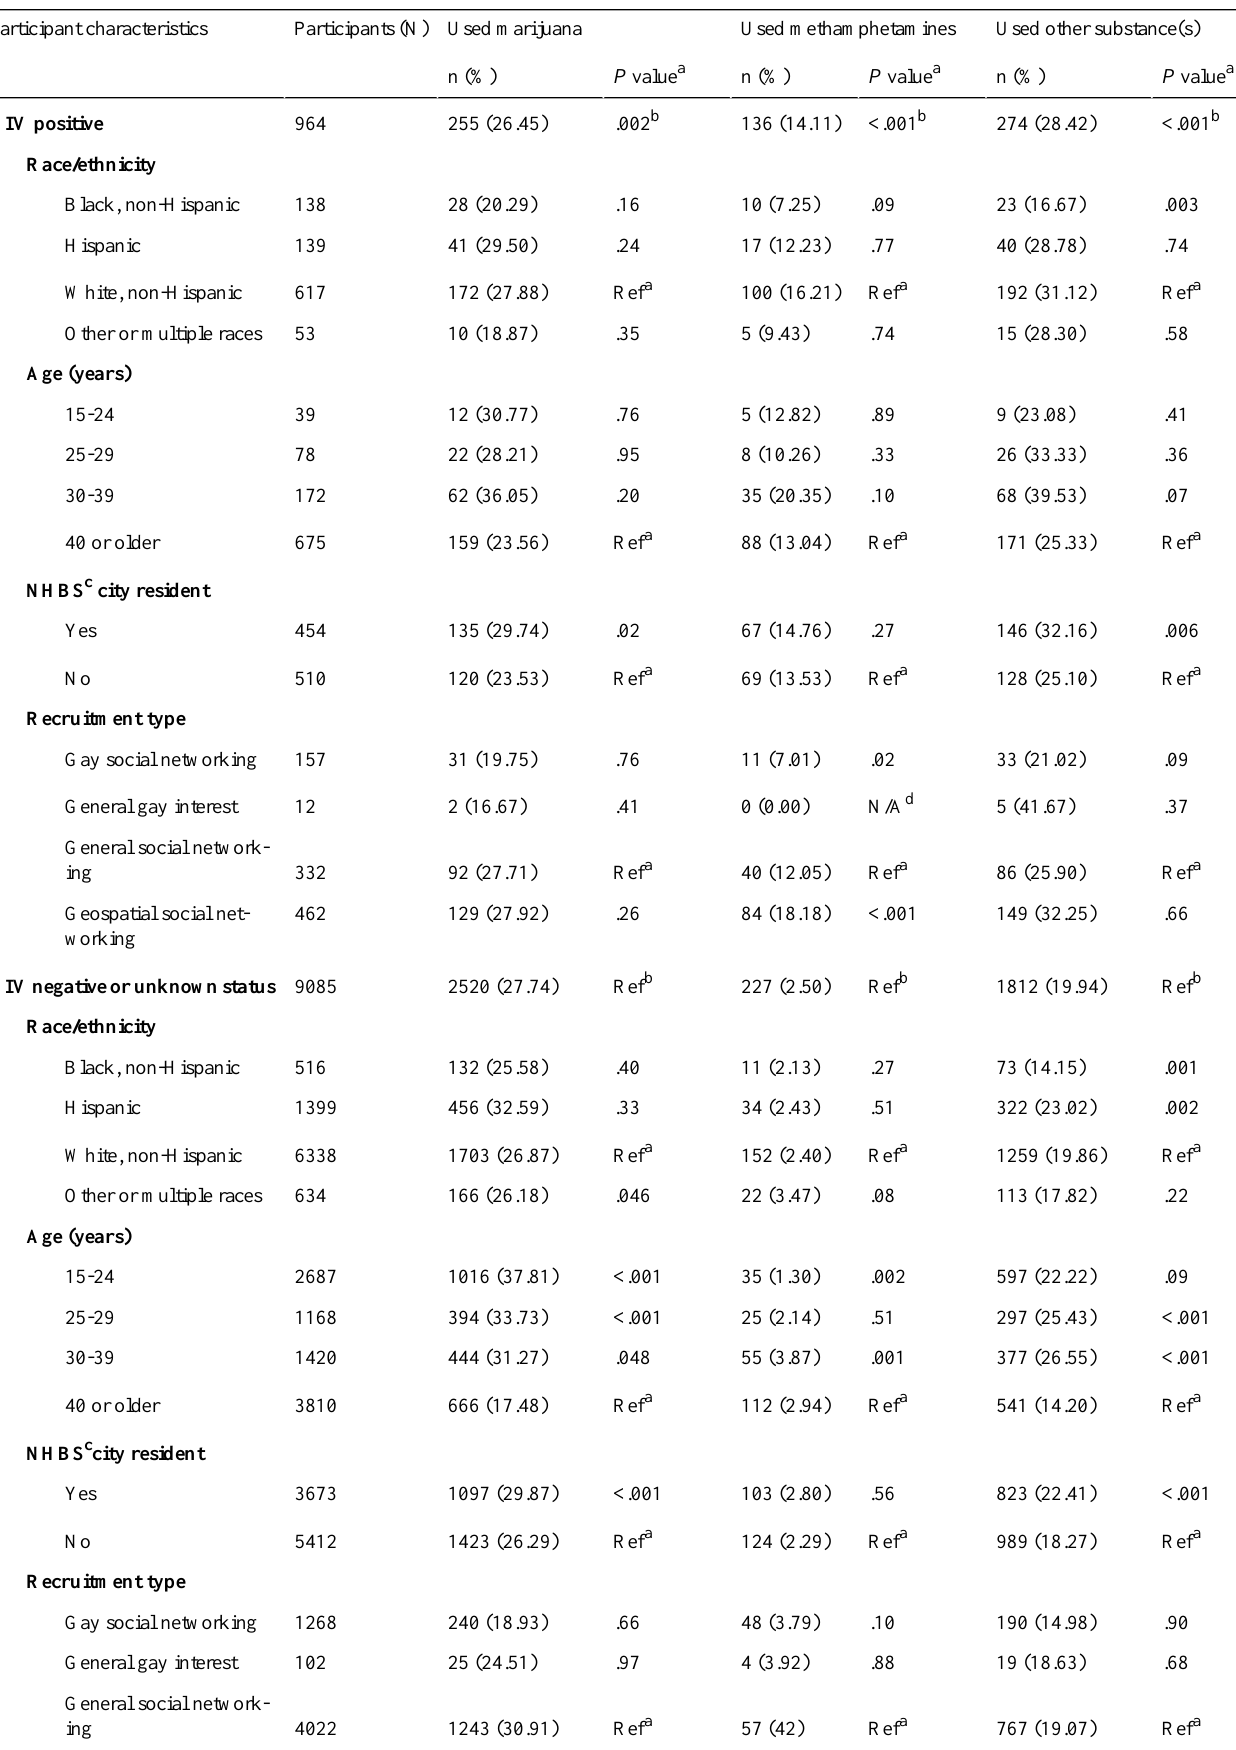
Table 4. Substance use behaviors of men who have sex with men in the American Men’s Internet Survey, United States,